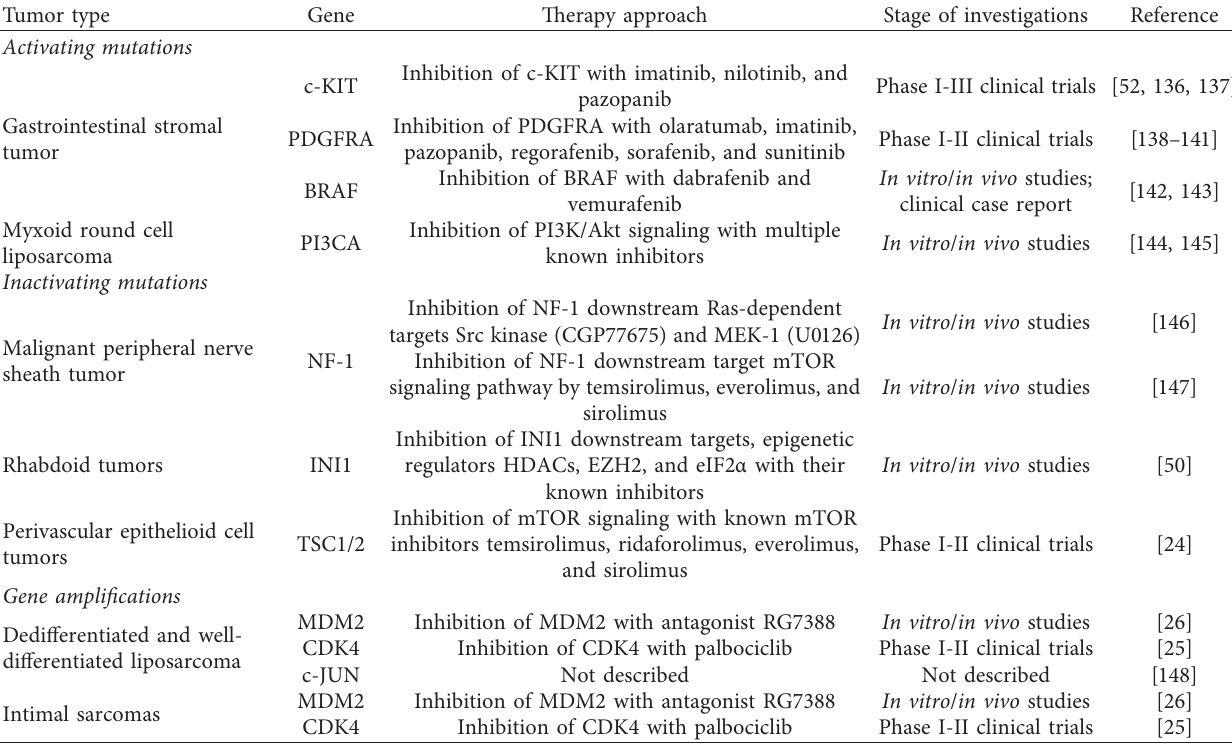
Table 2: Oncogenic mutations and gene amplifications in